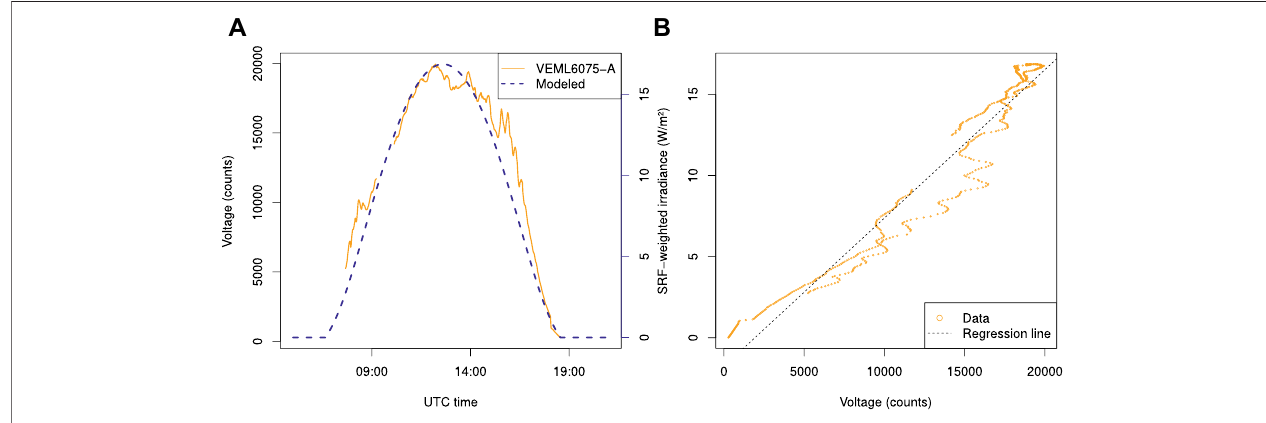
FIGURE 9 | Comparison of model estimations and VEML6075.1-A measurements: diurnal evolution (A) and regression (B) .